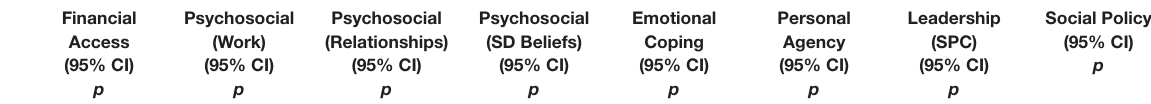
TABLE 9 | Total effects for the mediation SEM Model